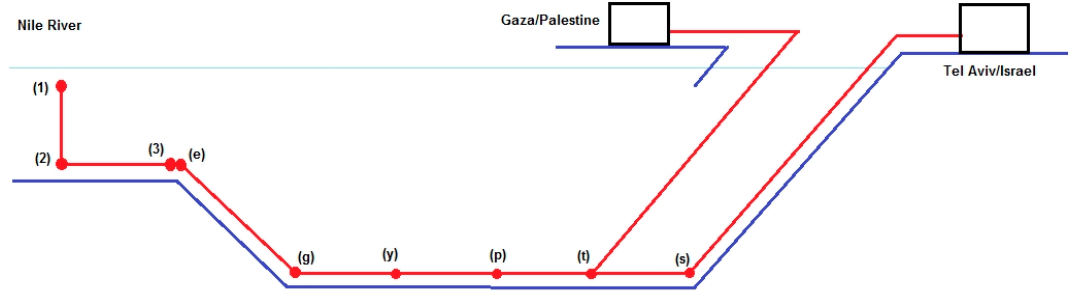
Figure 12. Stretches of the route of the underwater pipeline River Nile/Tel Aviv-Gaza. Table 5. Characterization of Pipelines River Nile/Tel Aviv-Gaza. Scenario 1 (200 L/capita/day), Scenario 2 (81 L/capita/day).